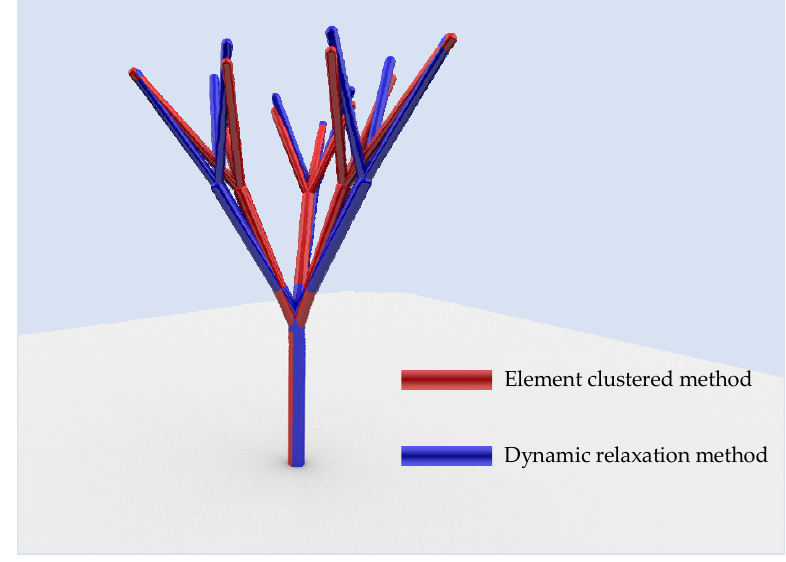
Figure 4. Comparison of the branching structures generated by two methods.